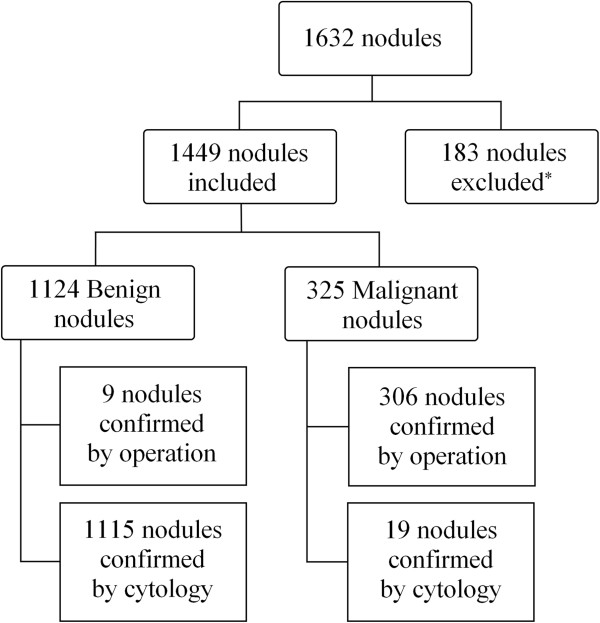
Diagram of the study group. *Exclusion criteria in the result.